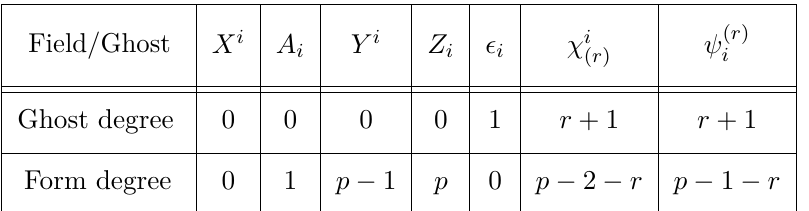
Table 1 . The fields and ghosts of the twisted R-Poisson sigma model in p + 1 dimensions. The range of r is r = 0 , . . . , p − 1 and we make the identifications χ i collective notation for the p − 1 ghosts χ and the p ghosts ψ . Obviously, χ i does not